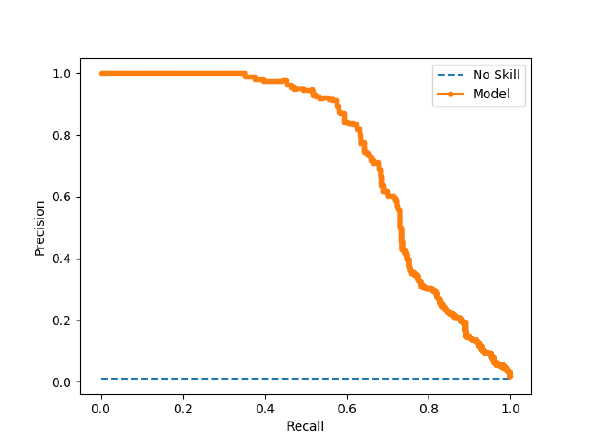
Figure 6. Precision-Recall curve